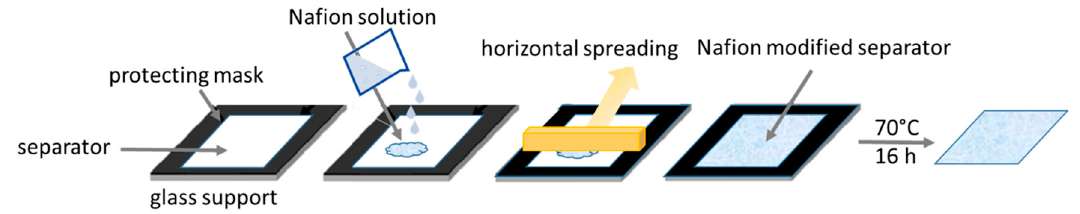
Figure 1. Schematic procedure of separator modification.